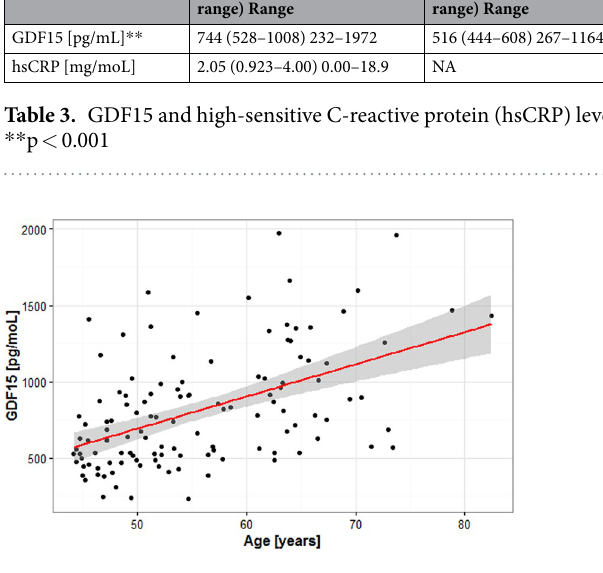
Figure 1. Plasma GDF15 levels are correlated with age in psychosis patients. Spearman’s ρ = 0.496, β = 0.494, p < 0.001. Standardized